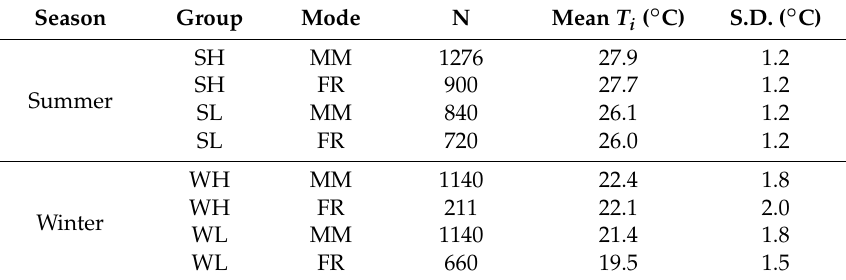
Table 2. Temperature differences of the groups in different modes.